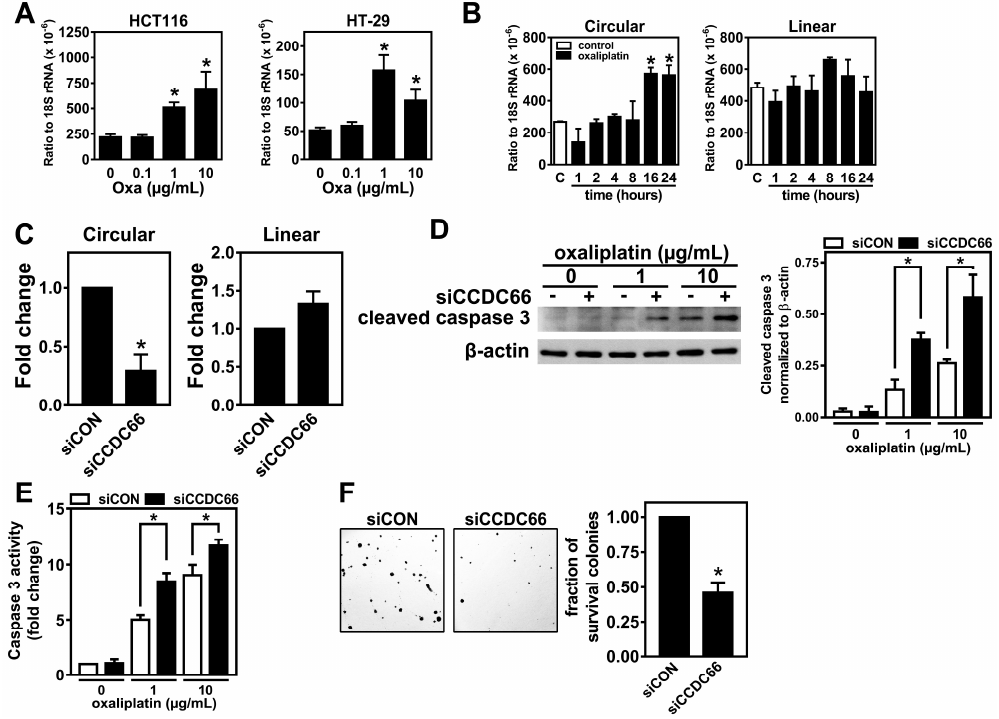
Figure 3. Expression of circCCDC66 is induced by oxaliplatin treatment. ( A ) Levels of circCCDC66 in CRC cell lines treated with oxaliplatin (Oxa) at indicated doses (Left: HCT116; Right: HT-29). ( B ) Levels of the circular transcript and mRNA (linear transcript) of CCDC66 in HCT116 treated with oxaliplatin (1 µg/mL) for the indicated times. ( C ) Levels of the circular transcript and mRNA (linear transcript) of CCDC66 from HCT116 transfected with control siRNA (siCON) or siRNA targeting circCCDC66 (siCCDC66). ( D ) The representative images for cleaved caspase 3 and β-actin from HCT116 cells transfected with control siRNA (siCON) or siRNA targeting circCCDC66 (siCCDC66) and followed by a treatment with oxaliplatin at the indicated doses for 48 h (left). Quantitative result is shown on the right panel. ( E ) Caspase 3 activities from cells with the indicated treatments. ( F ) Representative images for a clonogenic assay performed in HCT116 cells transfected with control siRNA (siCON) or siRNA against circCCDC66 (siCCDC66) and treated with 1-µg/mL oxaliplatin for more than 7 days. * denotes p < 0.05.